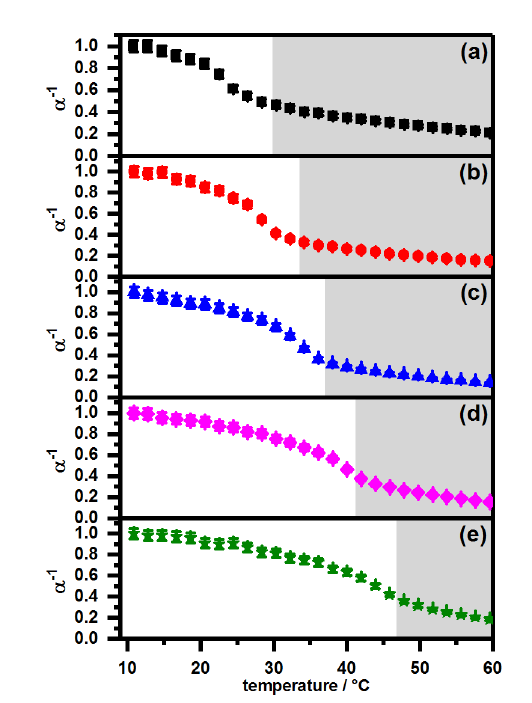
Figure 7. PCS swelling curves at pH 7 of the samples ( a ) PNN100/PMAM0 (black squares); ( b ) PNN75/PMAM25 (red circles); ( c ) PNN50/PMAM50 (blue triangles); ( d ) PNN25/PMAM75 (magenta diamonds) and ( e ) PNN0/PMAM100 (olive stars). The region of the linear volume phase transition is highlighted by a grey